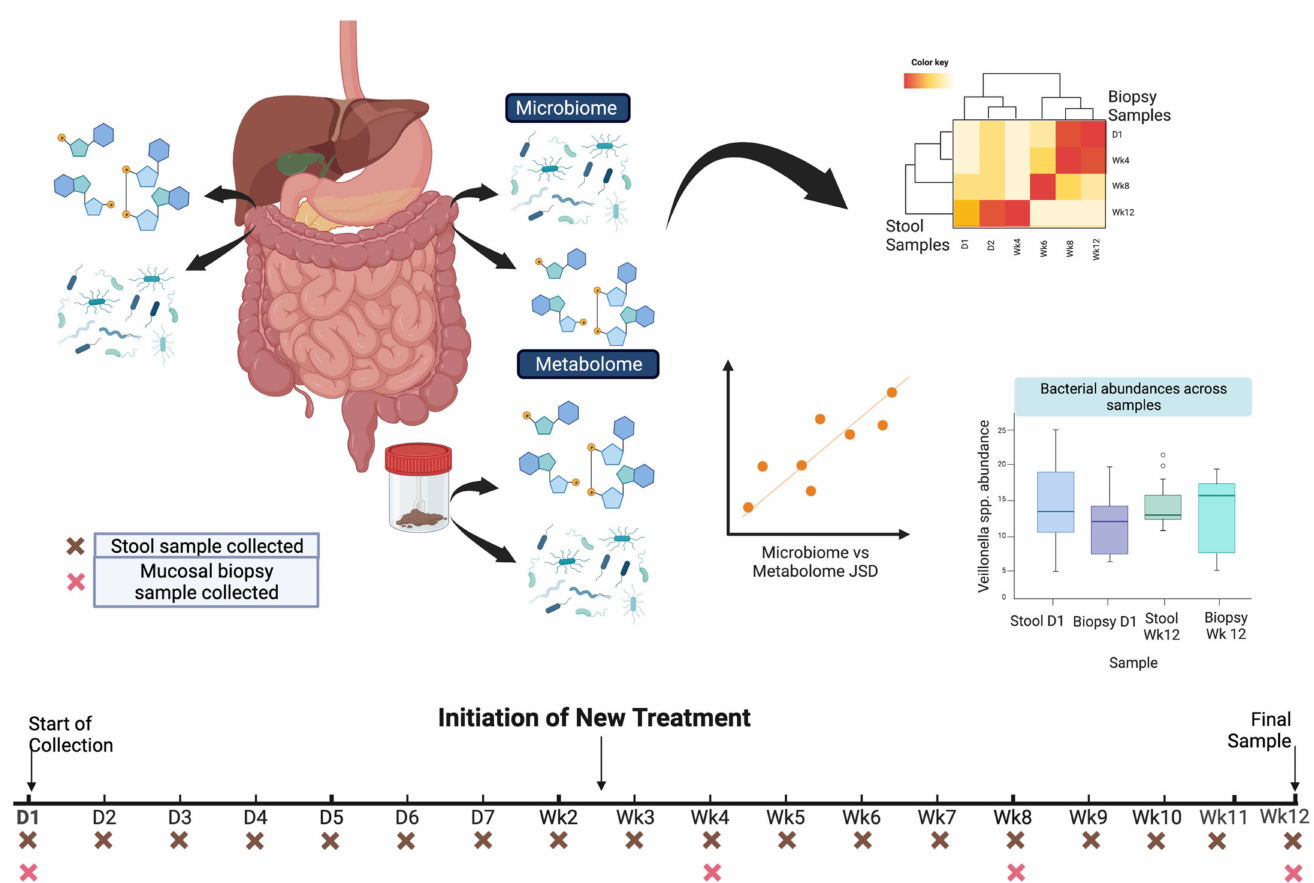
Figure 2. Example of a research design illustrating the benefits of using longitudinal multi-omics data in the context of evaluating changes in IBD treatment. Using stool and biopsy samples from multiple sites in the colon permits assessment of localized biosignatures that can be correlated for the development of diagnostics and therapeutics. Both pre- and post-treatment analyses facilitate the detection of biosignatures predicting therapeutic response. Using multi-omics data permits the inclusion of changes in the microbiome with genomic and metabolomic data—a holistic approach is also likely to generate